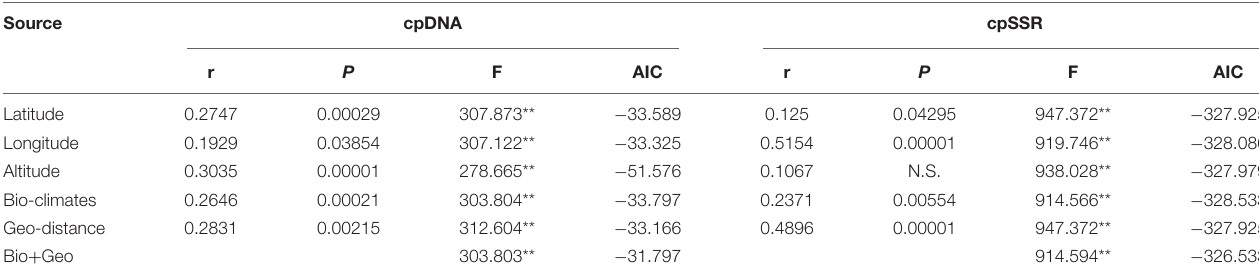
FIGURE 3 | Bidirectional historical gene flow among three groups calculated by Migrate-n. (A–D) The results generated by cpSSRs, Es-cpDNA3 + 4 + 5, matK, and rbcL respectively. TABLE 7 | Mantel test and the generalized linear mixed modeling (GLMM) between F st and geographical (IBD) and bio-climate (IBE) differences. Source cpDNA